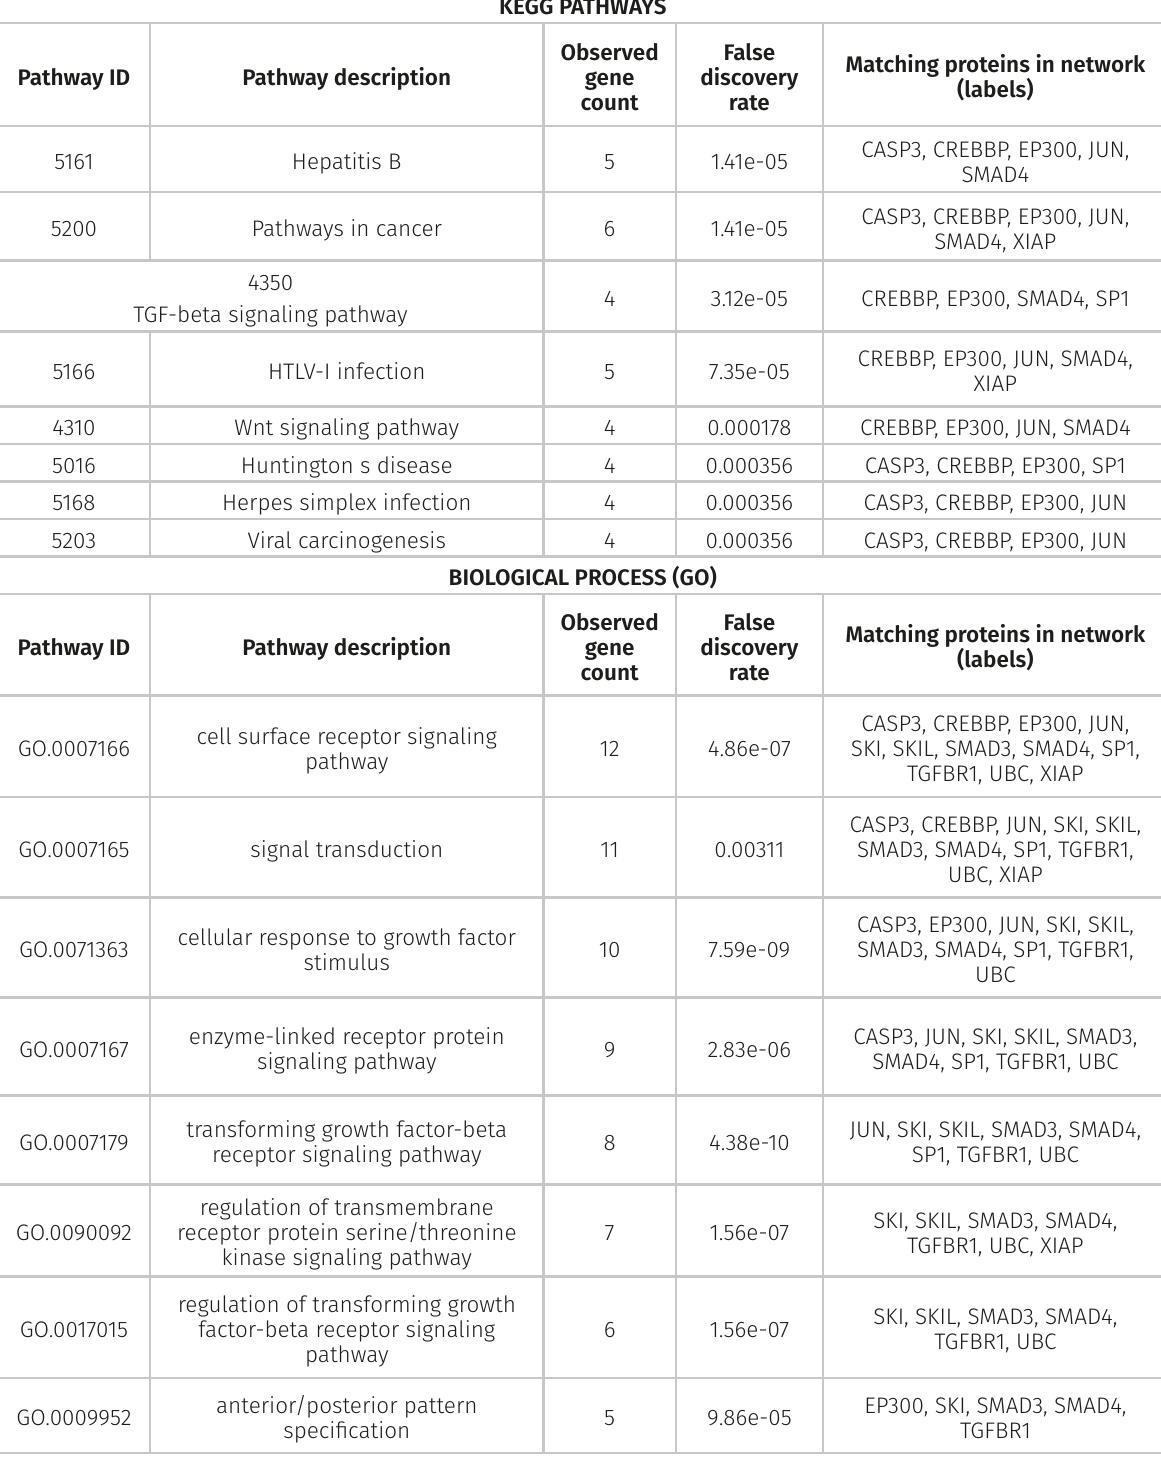
Table III. Categorization of genes according to their KEGG pathways, molecular functions, biological processes, cellular components, PFAM proteins domains, and INTERPRO proteins